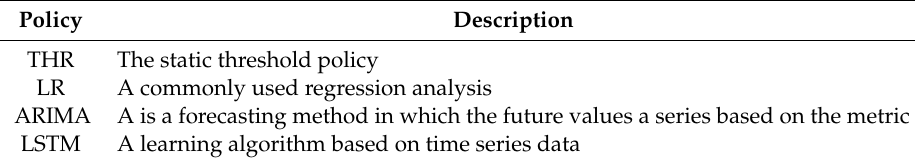
Table 11. Existing